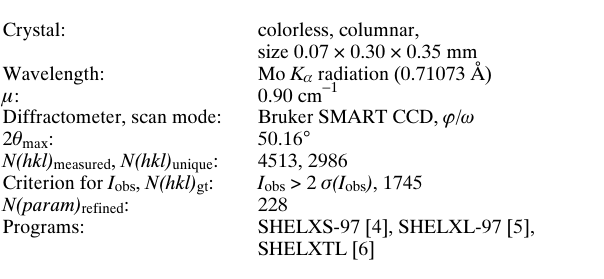
Table 1. Data collection and